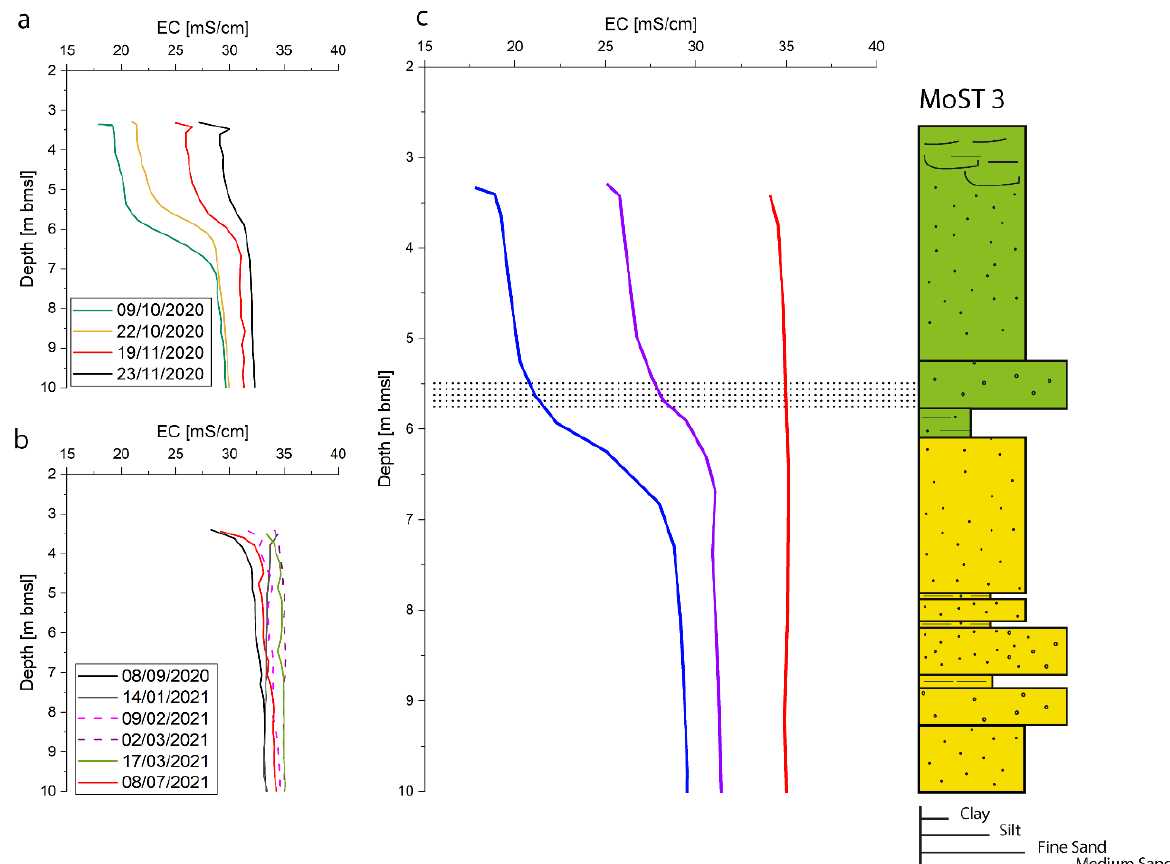
Figure 6. EC profiles collected in MoST3 well. Panels ( a , b ) show the configurations assumed by the EC curve during the observed period. The model of panel ( c ) summarizes the configurations and compares them with the stratigraphic section, outlining the sedimentary constraint (dotted area) existing in the subsoil surrounding the monitoring point.